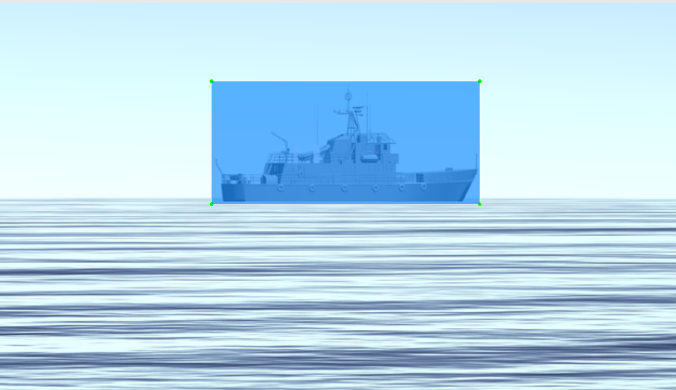
Figure 10. Labeled image. Blue means the box in which the object is